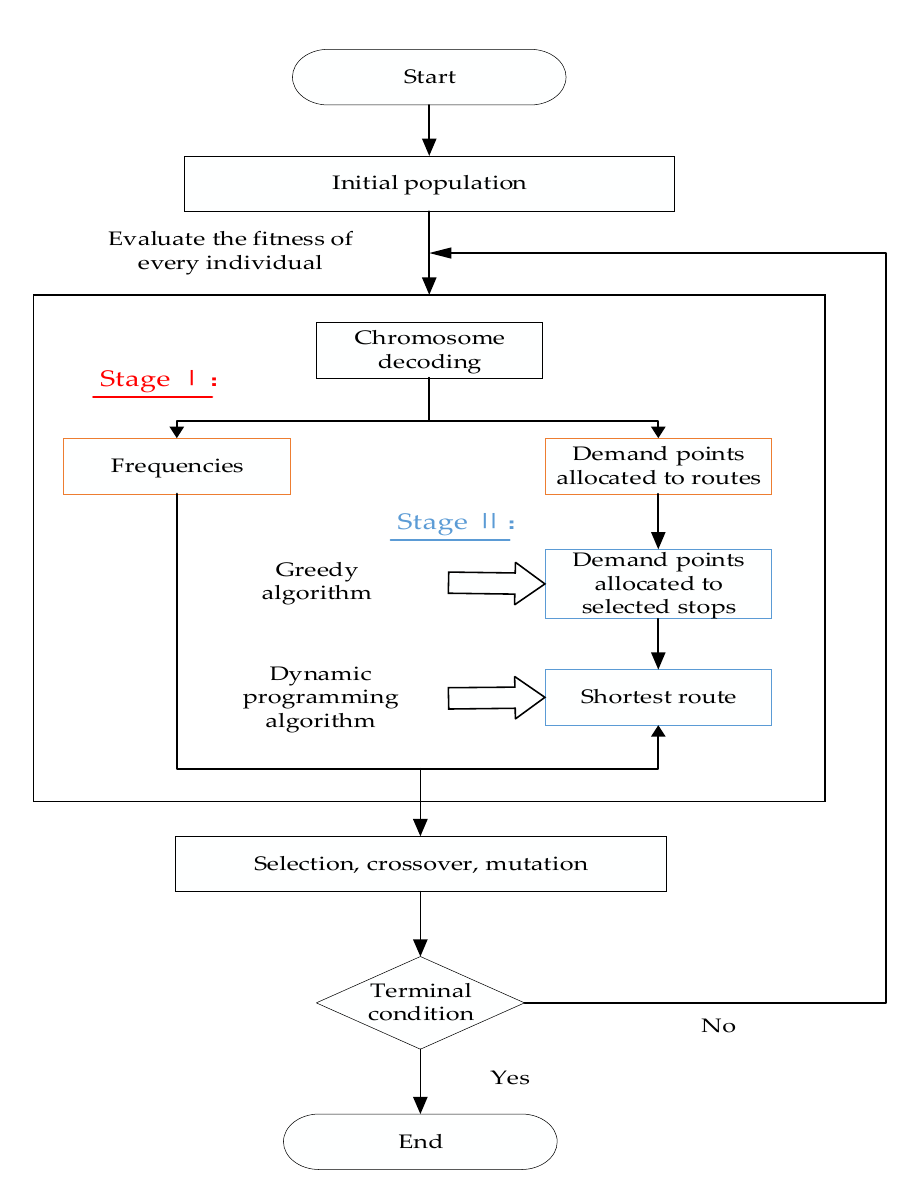
Figure 3. Flowchart of the NSGA ‐ II ‐ based two ‐ phase algorithm. 5.1. Phase I: Allocate Demand Points to Shuttle Bus Routes Using the NSGA ‐ II